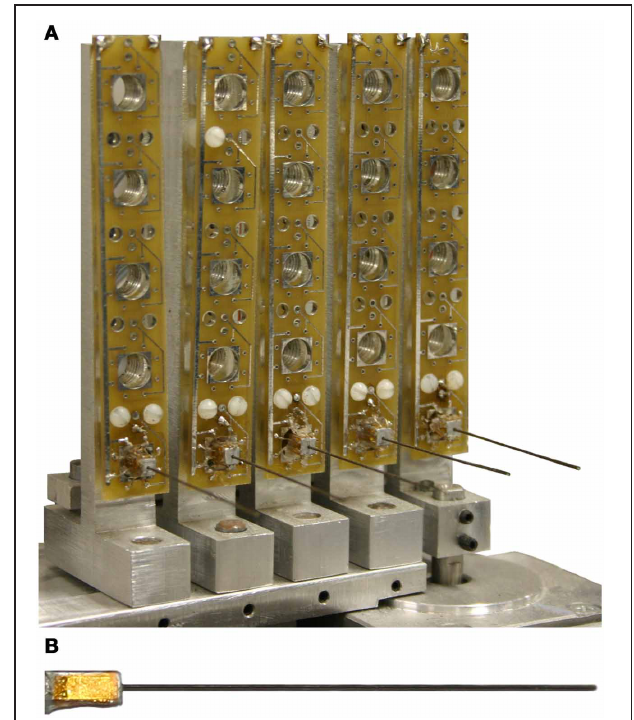
FIGURE 3 | (A) 5 × 5 whisker array on individual rotating platforms and (B) individual whisker composed of 4 350 ohm strain gauges measuring the bending moment of a 0.020 diameter superelastic Nitinol wire.